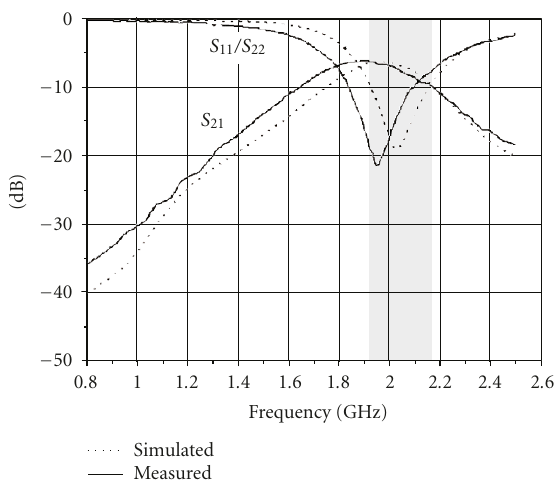
Figure 2: Simulated and measured S -parameters of the initial two- antenna system.